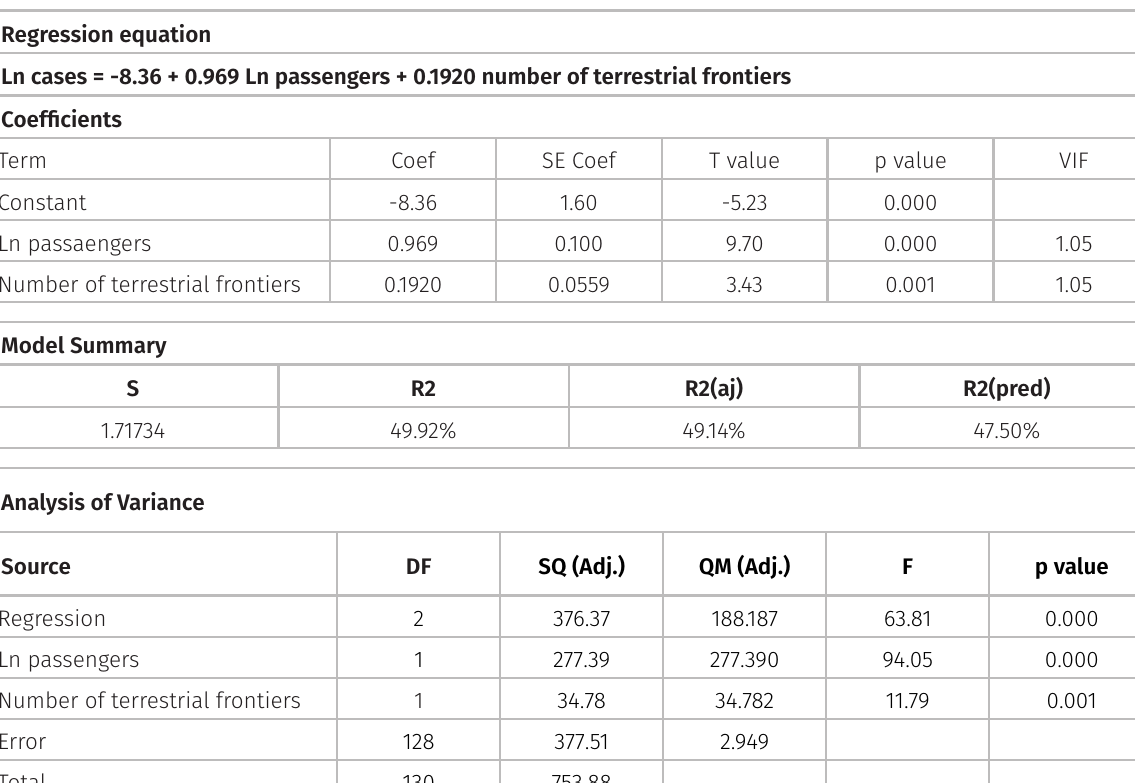
Table I. Stepwise regression summary for total COVID-19 cases by passengers and international frontiers. Regression